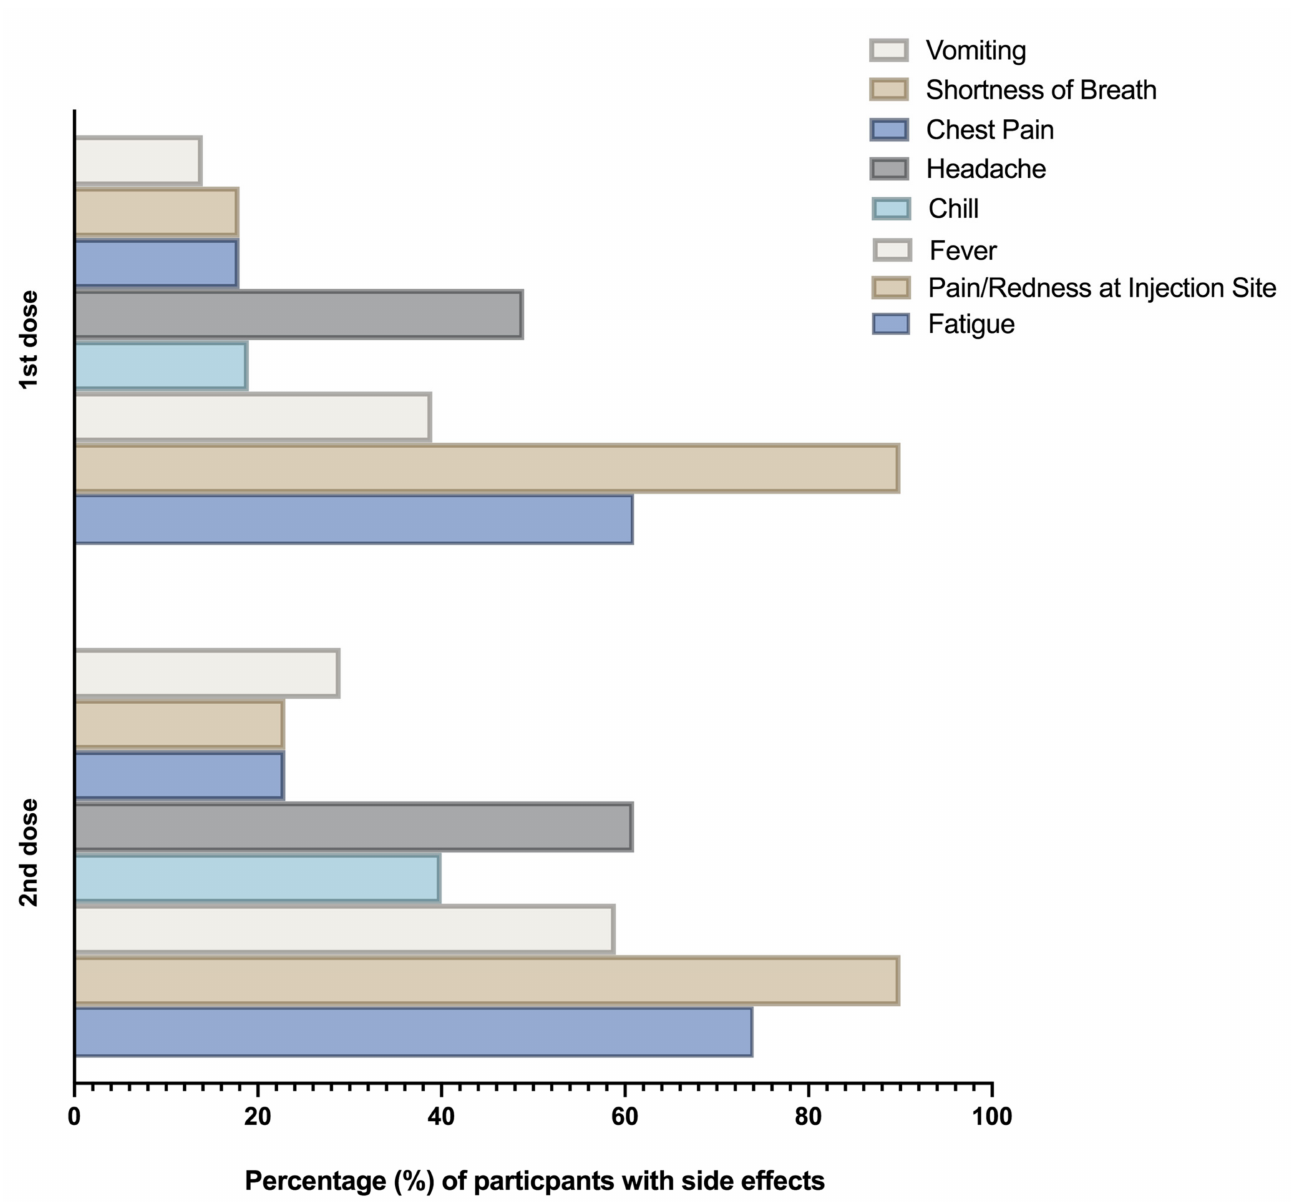
Figure 1. Comparison of side effects after either one or two doses of the Pfizer-BioNTech (BNT162b2) vaccine in the study